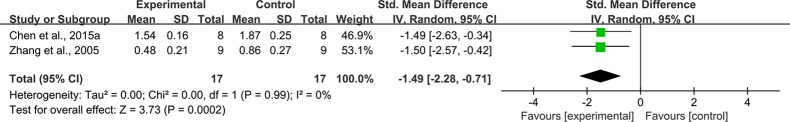
Pooled estimate of TGF-β1 with rhein.